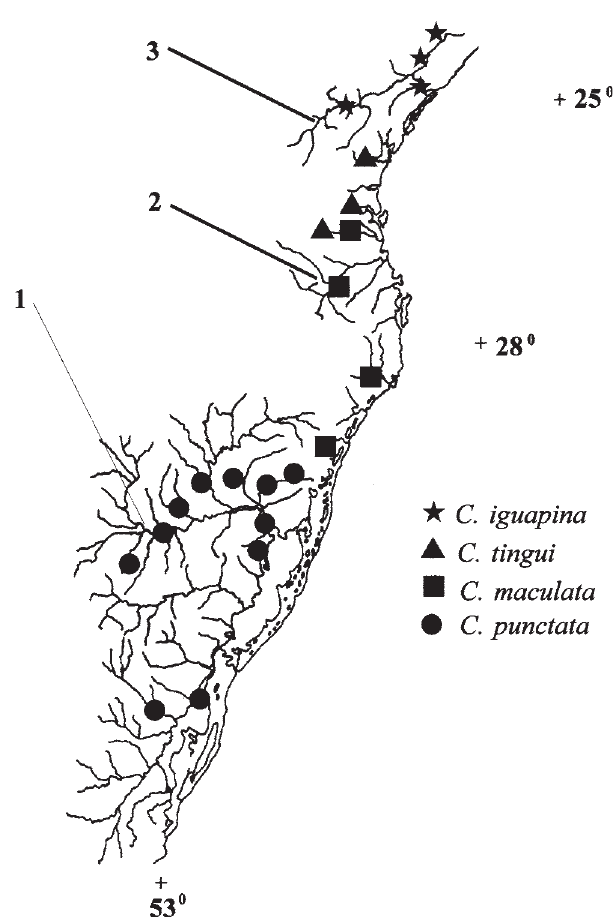
Fig. 6. Collecting localities of Crenicichla iguapina , C. tingui , C. maculata , and C. punctata in the coastal rivers of south- eastern Brazil. Most important rivers are: 1. Rio Jacui (part of the laguna dos Patos System); 2. Rio Itajaí-Açu; and 3. Rio Ribeira de Iguape. A symbol may cover more than one col- lecting site.